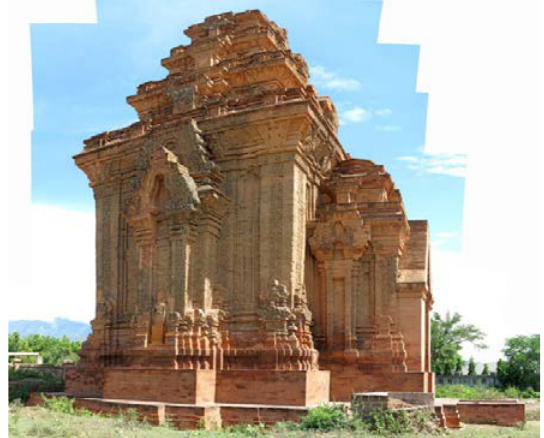
Figure 5. Hoa Lai East tower